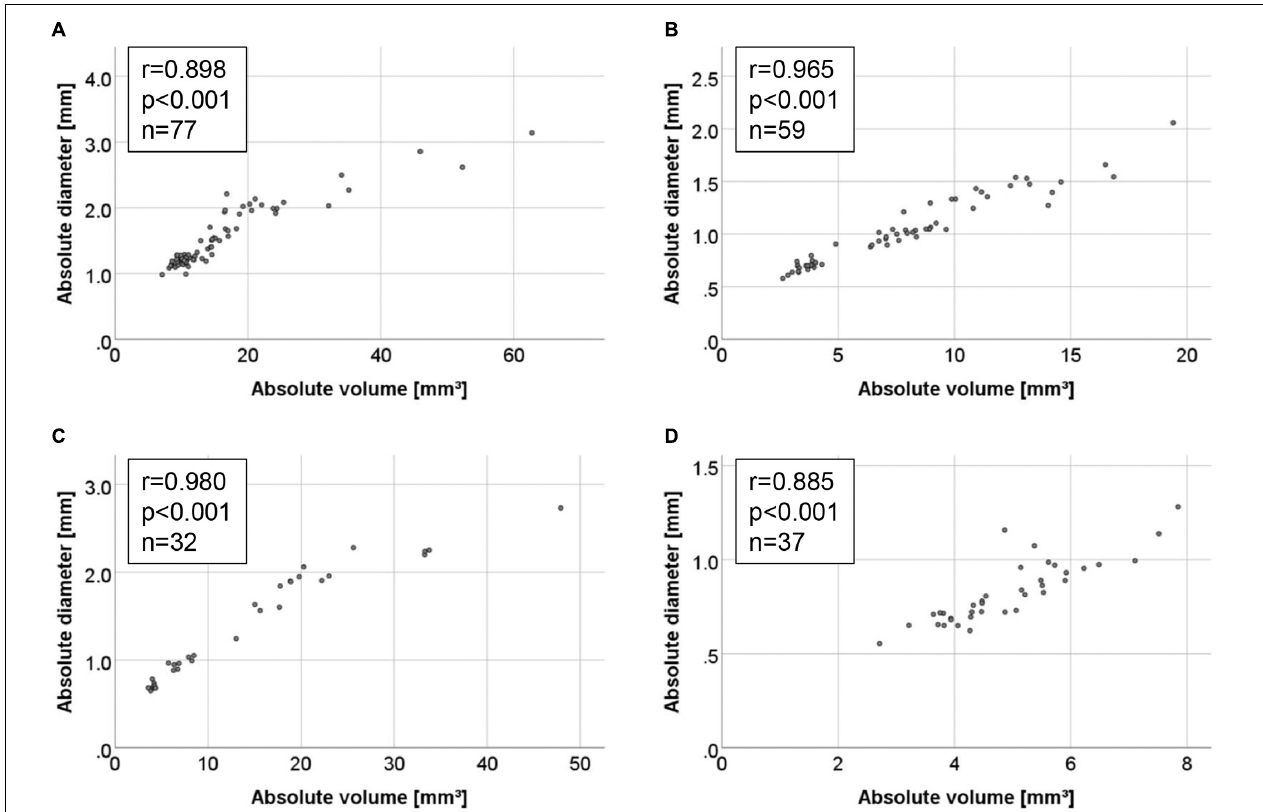
FIGURE 5 | Correlations between absolute measurements of 3D volume and maximum aortic diameter in the four AAA mouse models. Correlations are illustrated by scattergram for the (A) AngII model, (B) ePPE model, (C) ePPE + BAPN model, and (D) PPE model. Spearman coefficient of correlation is given for all measured values, including